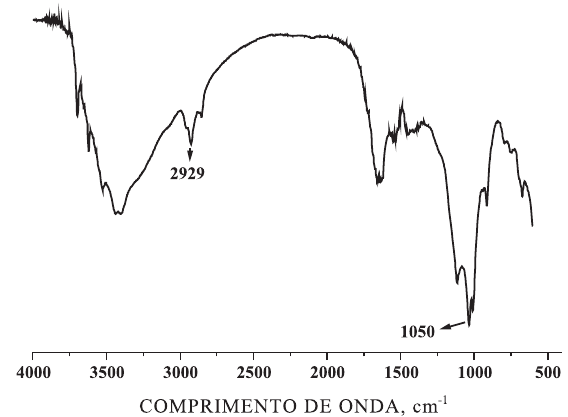
Figura 1. Espectro de infravermelho do lodo de esgoto utilizado no